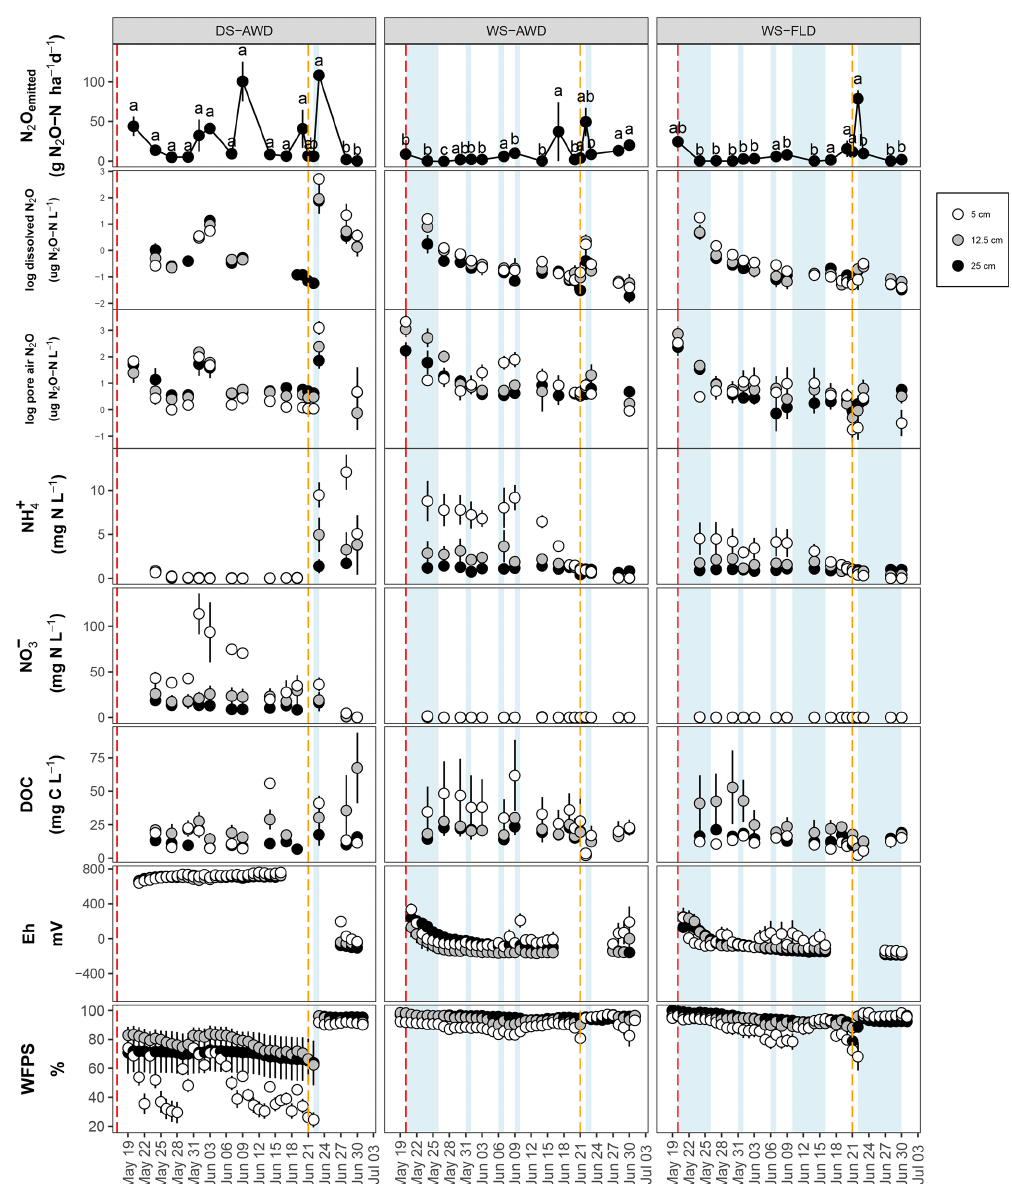
Figure 2. N 2 O surface emissions, log 10 of dissolved and pore air N 2 O concentrations, NH + field measurement period in the three water management treatments (WS-FLD: water-seeding + conventional flooding; WS-AWD: water- seeding + alternate wetting and drying; DS-AWD: direct dry seeding + alternate wetting and drying). The dashed vertical line indicates the date of fertilization (60kg urea-Nha − 1 ). Blue shaded areas represent periods of flooding; shaded areas that last only 1 day indicate “flush irrigation”, i.e., flooding for <6h. The error bars represent the standard error of the mean. Red and orange dashed vertical lines represent the date of seeding and fertilization in each treatment,